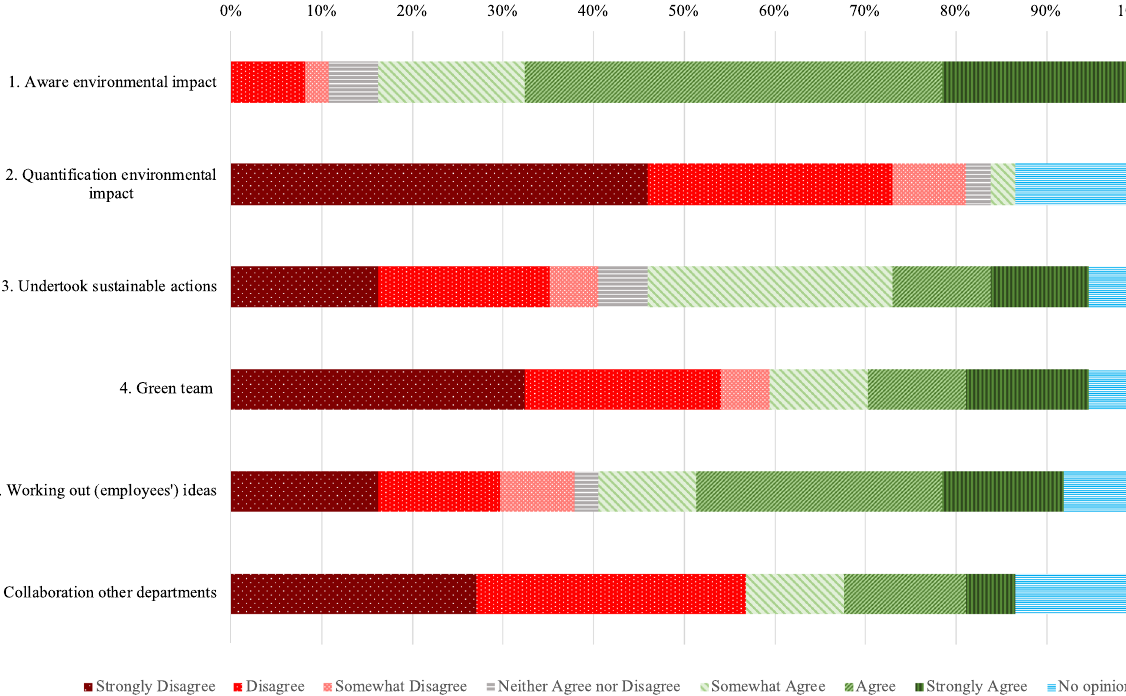
Fig. 1 Results of online